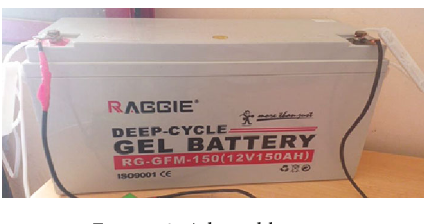
Figure 8: Adapted battery. Table 2: The intensity according to the inclination.